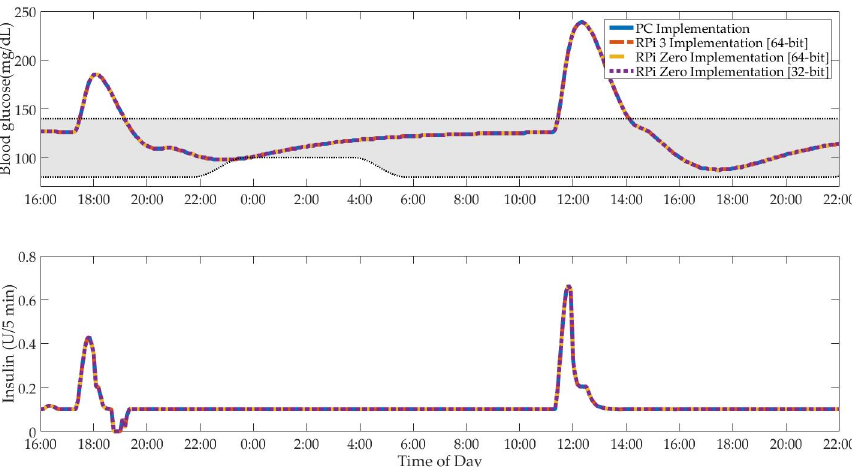
Figure 5. (Top) Comparison of glucose regulation with zone-MPC implemented on a PC, on Raspberry Pi 3 and Raspberry Pi Zero for 50-g and 70-g unannounced meal (blue, red, yellow lines). Comparison of glucose regulation with zone-MPC implemented on Raspberry Pi Zero with multiple bit precisions for quadratic programming problem (QP) solving and associated computations (yellow and purple lines). (Bottom) Comparison of optimal insulin levels computed by the different implementations.